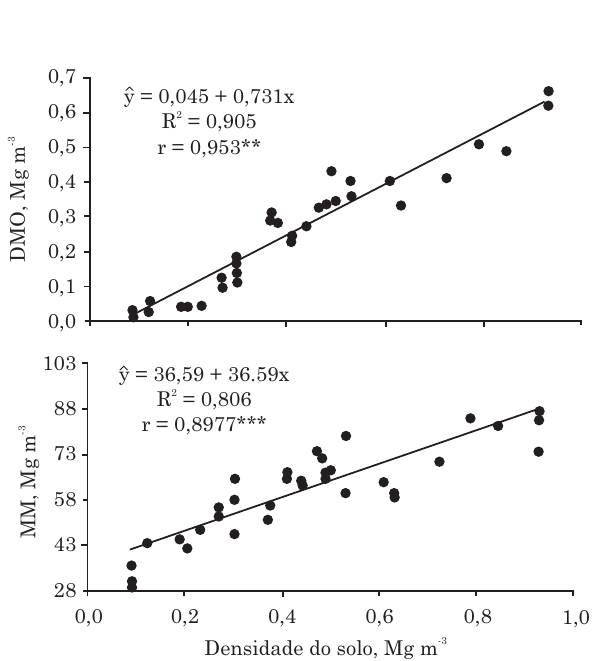
Figura 2. Correlação entre (a) densidade do solo (Ds) e densidade da matéria orgânica (DMO) e (b) densidade do solo (Ds) e % de material mineral (%MM).